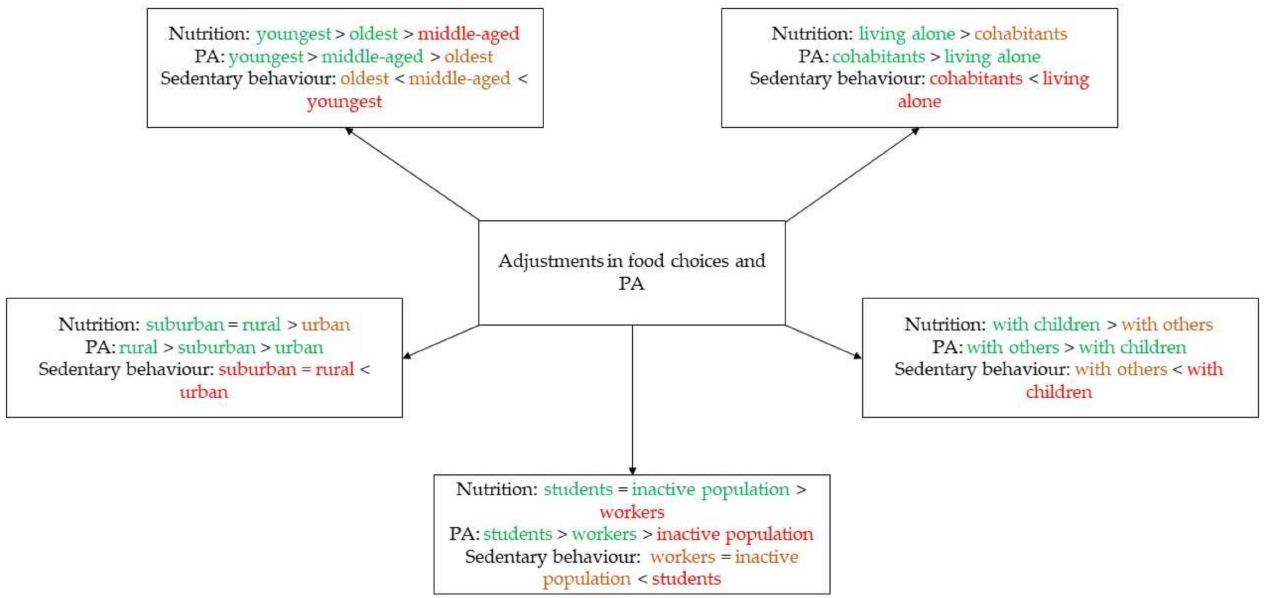
Figure 1. Schematic overview of the results about the relationship between adjustments in food choices and PA with variables such as age, area of residence, home situation, family situation and work